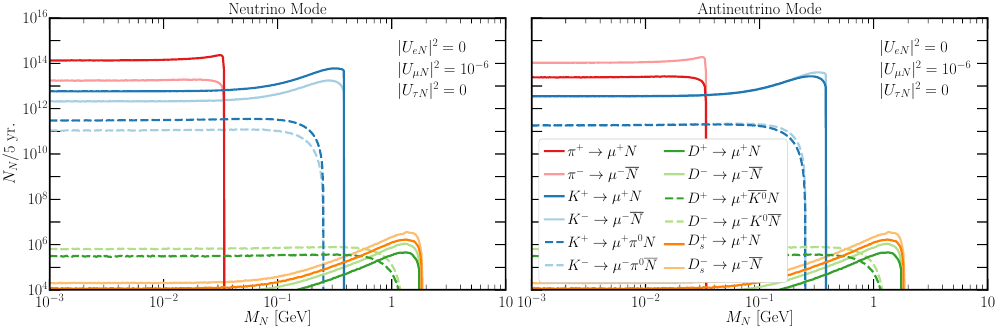
Figure 19 . Number of muon-coupled heavy neutral leptons N traveling toward the DUNE MPD as a function of mass M N , assuming (cid:12)ve years of data collection in neutrino mode (left) or antineutrino 2 = 10 (cid:0) 6 . Di(cid:11)erent meson-decay contributions are indicated mode (right). We have (cid:12)xed U (cid:22)N j j by di(cid:11)erent colors: pions (red), kaons (blue), D mesons (green), and D s mesons (orange). For each meson, darker colors indicate positively-charged meson decays, where fainter colors indicate negatively-charged meson decays. Dashed curves indicate three-body meson